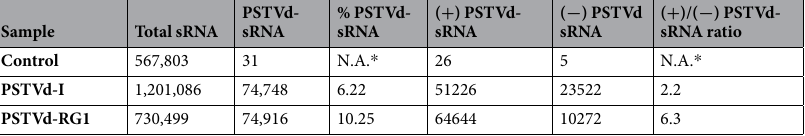
Table 1. Potato spindle tuber viroid (PSTVd)-sRNA reads found in the tomato cv. Rutgers leaf tissue infected with PSTVd-I and PSTVd-RG1. * Not